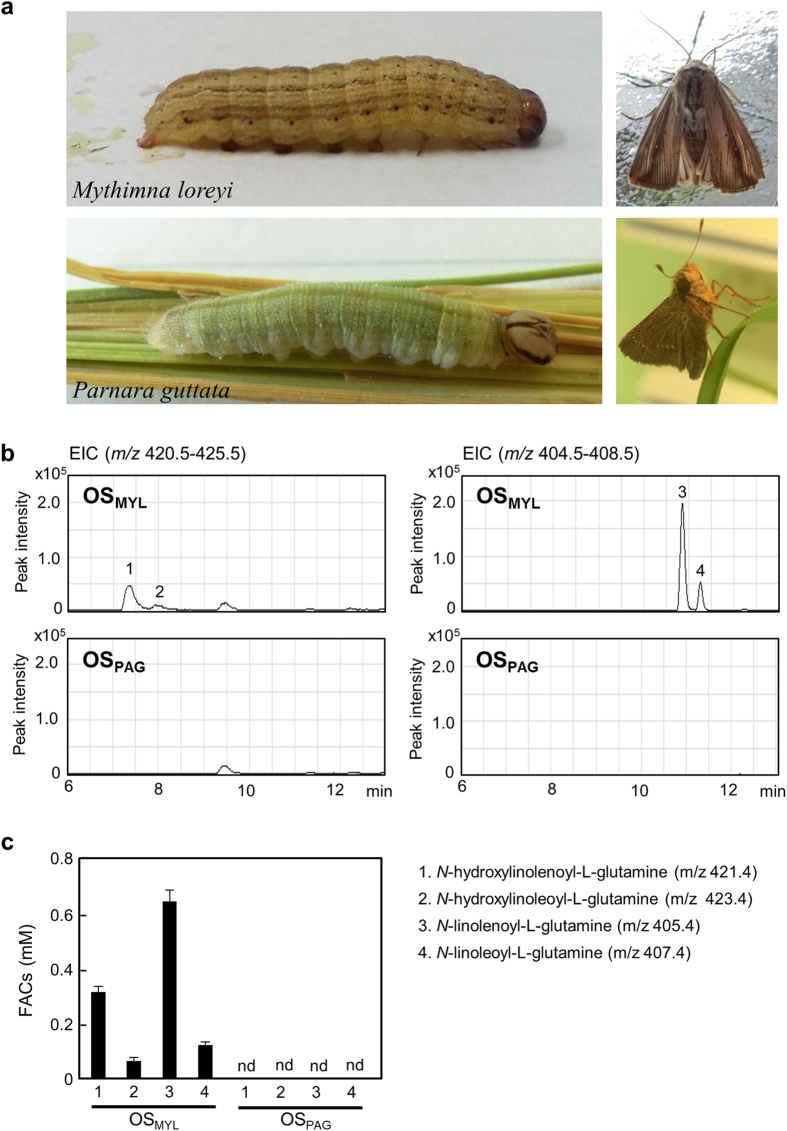
FAC composition and content in oral secretions from M. loreyi and P. guttata.(a) Caterpillars (left) and adults (right) of M. loreyi (OSMYL) and P. guttata used in experiments. (b) FAC composition in oral secretions from M. loreyi (OSMYL) and P. guttata (OSPAG) determined by LC-MS operating in negative scan MS mode (m/z range 150–1000); typical extracted ion chromatograms (EICs) of similarly diluted OSMYL and OSPAG samples are shown at unified y-axes scales for direct comparison. (c) The FACs in individual isolates of OSMYL and OSPAG were determined as above and total FAC concentration in each batch of OS were estimated by pooling individual FAC peaks, and using synthetic FAC, N-linolenoyl-L-Gln as calibration standard. “nd” refers to samples with no FAC detected. Data (n = 3) are shown as means ± SD.